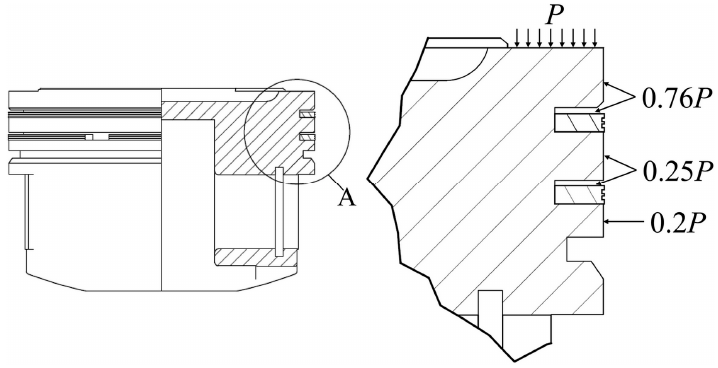
Figure 5. Pressure distribution of piston ring group and cylinder liner system.